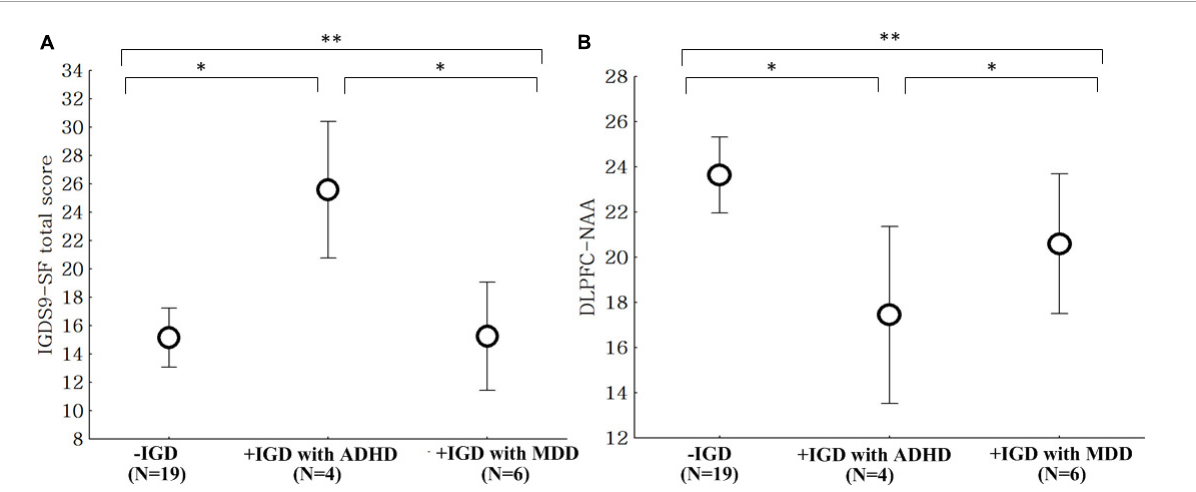
FIGURE2 Comparison of the IGDS9-SF scores and NAA level. IGDS9-SF, internet gaming disorder scale-short; NAA, N-acetyl-aspartate. (A) Comparison of the IGDS9-SF total scores between the low risk for internet gaming disorder group (–IGD), high risk for internet gaming disorder with attention deficit hyperactivity disorder group (+ IGD with ADHD), and high risk group for internet gaming disorder with major depressive disorder group (+ IGD with MDD). ∗∗ ANOVA, F = 8.42, p = 0.001, ∗ post hoc : p < 0.05, –IGD and + IGP with MDD < + IGP with ADHD. (B) Comparison of the NAA level within the dorsolateral prefrontal cortex (DLPFC) between the low risk for internet gaming disorder group (–IGD), high risk for internet gaming disorder with attention deficit hyperactivity disorder group (+ IGD with ADHD), and high risk for internet gaming disorder with major depressive disorder group (+ IGD with MDD). ∗∗ ANOVA, F = 5.06, p = 0.011, ∗ post hoc : p < 0.05, –IGD and + IGP with MDD > + IGP with